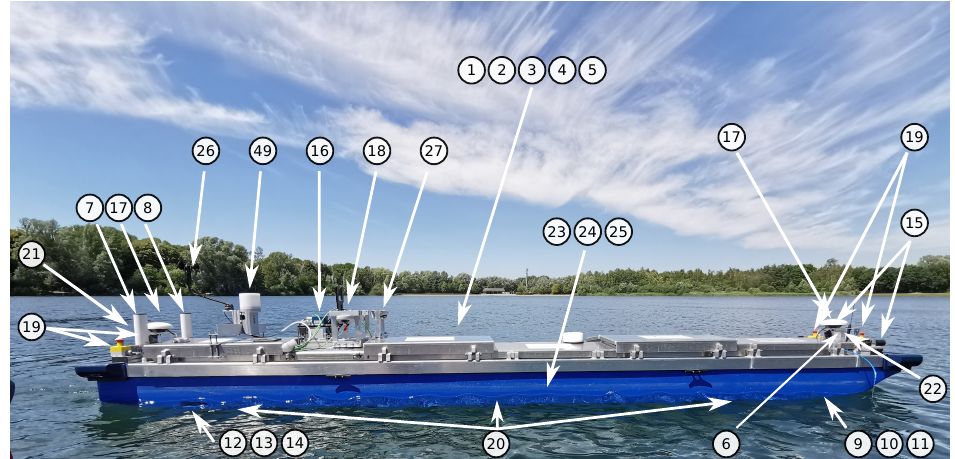
Figure 10. Positions of the main onboard USV components, referring to Table A1. Note that the LIDAR (number 18) was not mounted, but can be seen in Figure